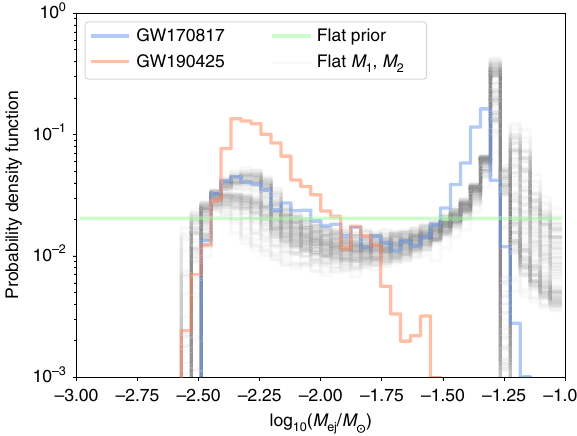
Fig. 8 Potential prior distributions for M ej . In addition to the fl at prior used in this analysis, we show ejecta mass distributions for GW170817 6 and GW190425 64 based on the fi t of ref. 35 . We also include distributions fl at in the component masses with 100 nonparametric EOSs consistent with GW170817 from ref. 65